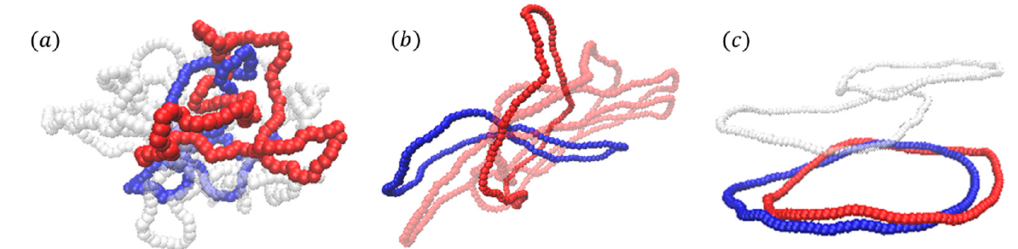
Figure 5. Illustration of typical threading structures of 0 1 -knot rings with different bending energies. ( a ) K b = 5, flexible rings adopt coiled conformation. ( b ) K b = 25, the semi-flexible rings pierce others forming a deep penetration. ( c ) K b = 80, rigid rings get parallel with each other resulting in a slight